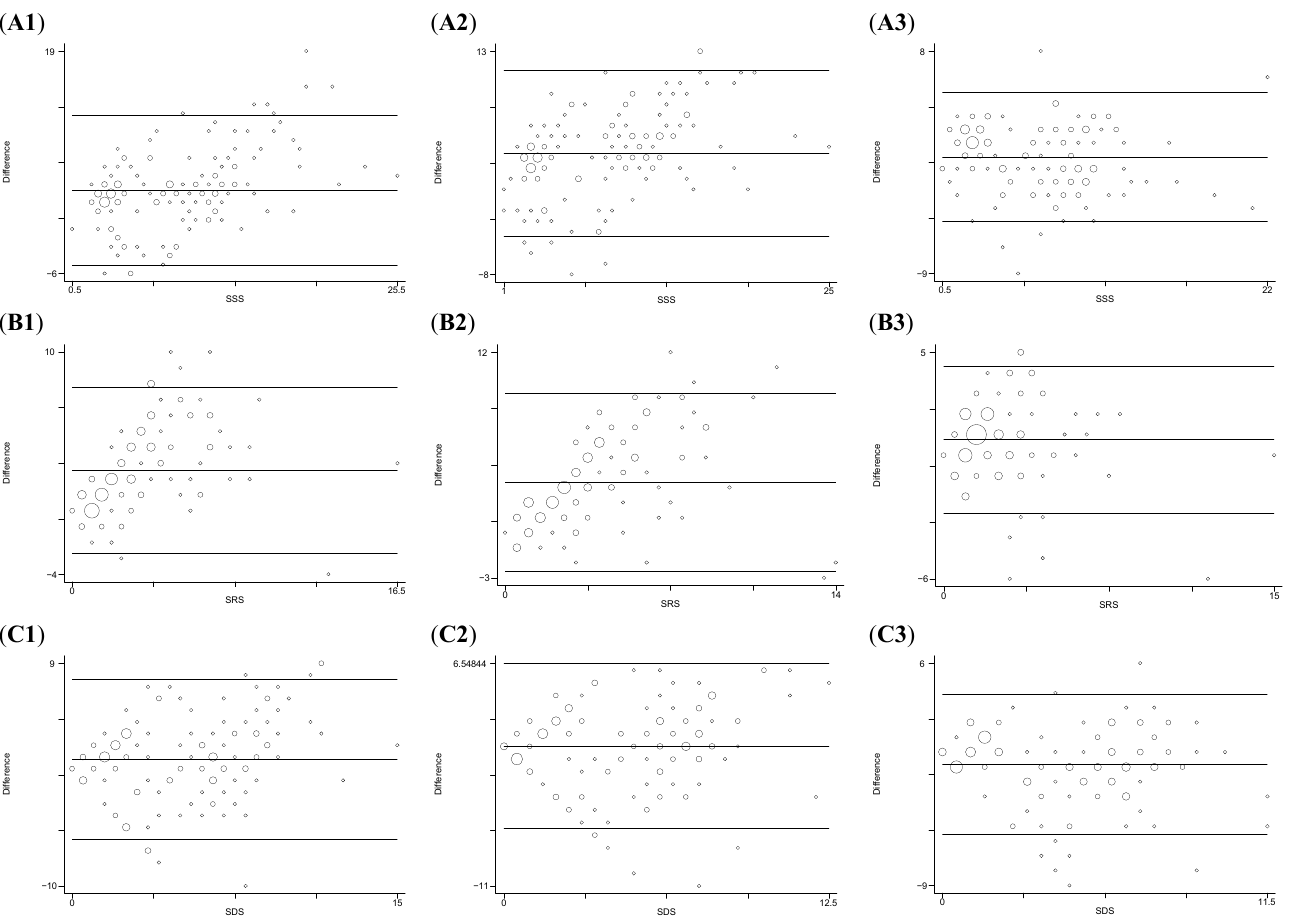
summed difference score; SRS: summed rest score; SSS: summed stress score. Bland-Altman plots for SSS, SRS and SDS are presented in Figure 1. For SSS, limits of agreement between ER and ECTb ranged from − 5.07 to 11.82 (Figure 1(A1)), between ER and MYO from − 4.41 to 11.24 (Figure 1(A2)) and between ER and QPS from − 5.02 to 4.90 (Figure 1(A3)). For SRS, limits of agreement between ER and ECTb ranged from − 2.70 to 7.81 (Figure 1(B1)), between ER and MYO from − 2.54 to 9.31 (Figure 1(B2)) and between ER and QPS from − 2.83 to 4.35 (Figure 1(B3)). For SDS, limits of agreement between ER and ECTb ranged from − 6.02 to 7.64 (Figure 1(C1)), between ER and MYO from − 6.46 to 6.54 (Figure 1(C2)) and between ER and QPS from − 5.55 to 3.91 (Figure 1(C3)). Limits of agreement between ER and software packages were widely indicating that the average discrepancy between expert scoring and software analyses was large enough.